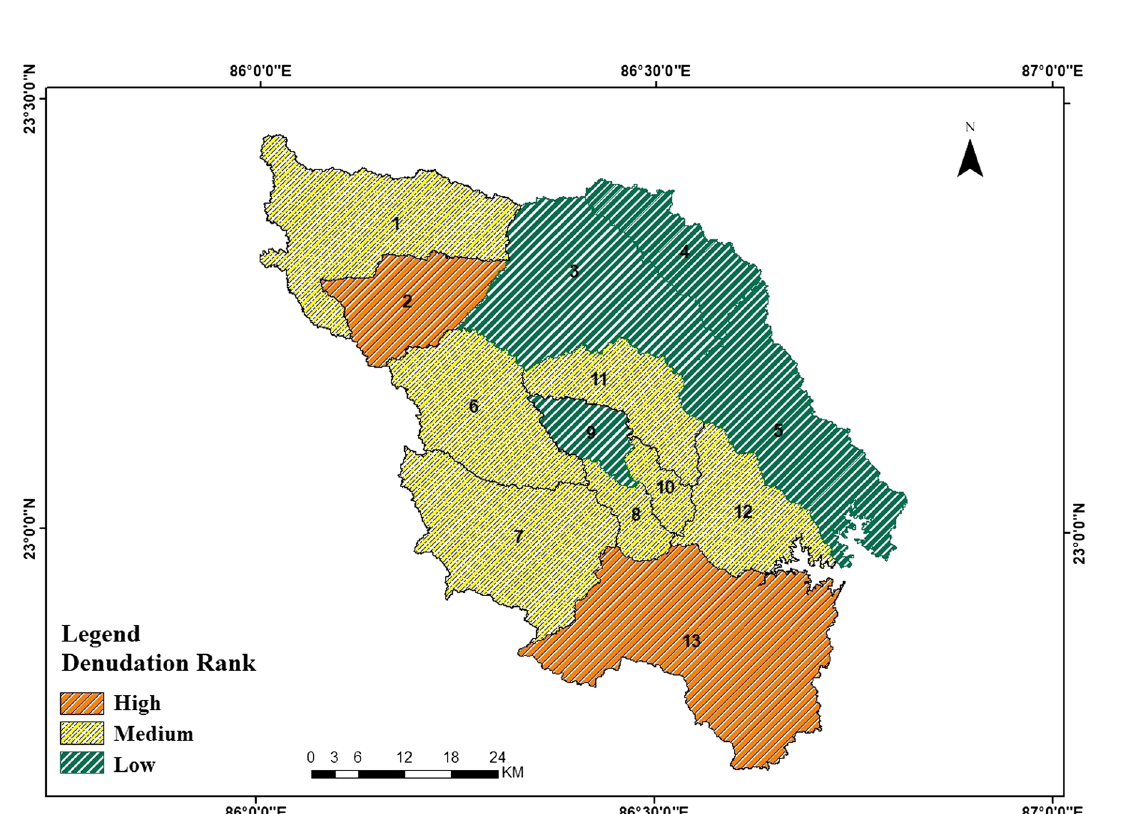
Fig. 12 Sub-basin-wise denudation rate in Kansai–Kumari reservoir catchment